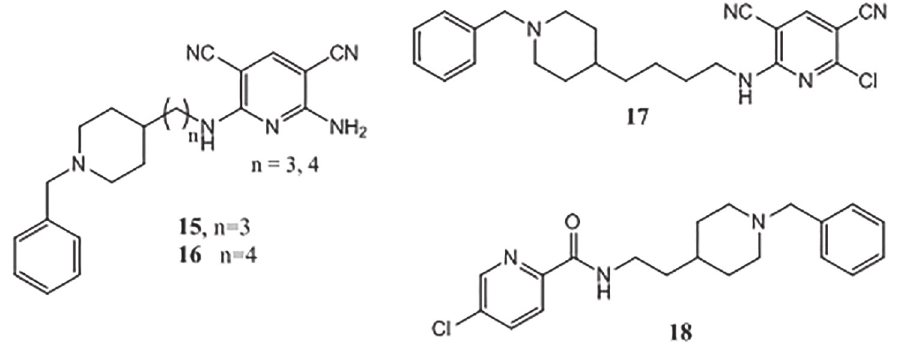
FIGURE 4 - Benzylpiperidine attached with heterocyclic